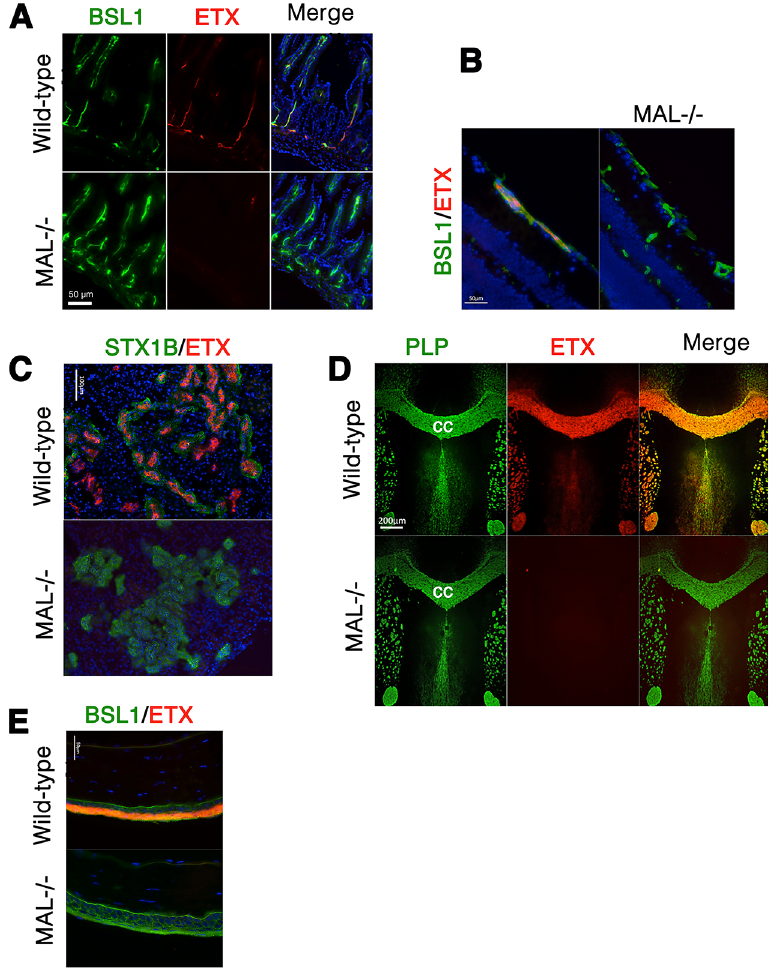
DAPI (blue) was counterstained to identify cell nuclei. Data are representative of at least three independent